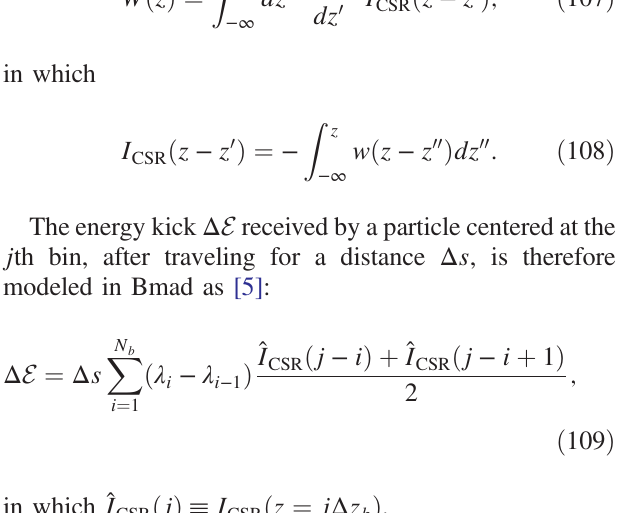
FIG. 23. Layout of CBETA. The sections labeled (IN) and (LA) are the injector and MLC cavities respectively. Sections (FA), (TA), (ZA), (ZB), (TB), and (FB) form the FFA beamline which accommodate all recirculating orbits with design energies rang- ing from 42 MeV to 150 MeV. Sections (SX) and (RX) are splitters and recombiners which control the path-length of each recirculation